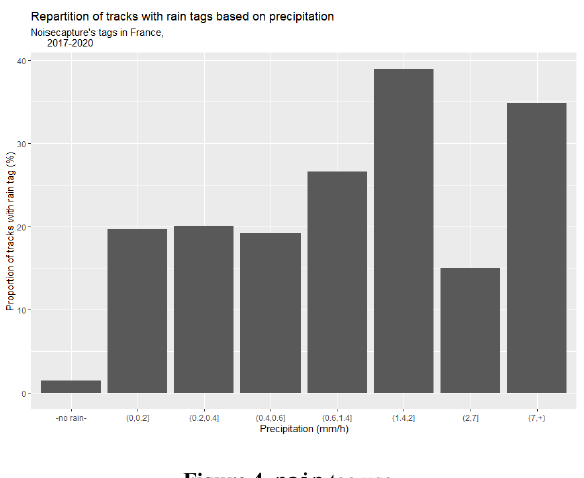
Figure 2. Animals acoustic dynamics.